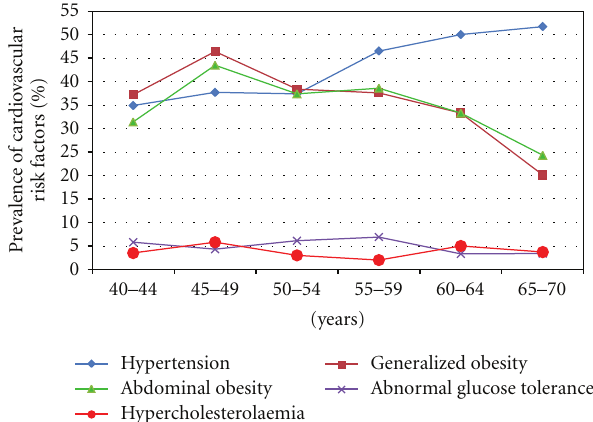
Figure 1: Trend of prevalence of cardiovascular risk factors within the age